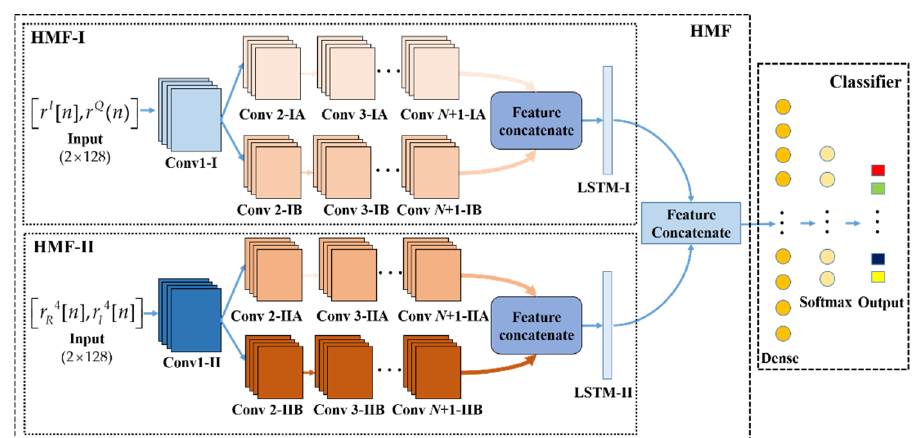
Figure 3. Illustration of the proposed hierarchical multifeature fusion scheme.